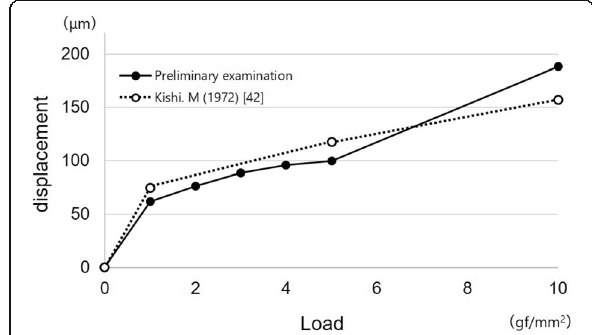
Fig. 6 Load displacement curve for the simulated mucosa. Black circles indicate data for the preliminary examination of the simulated mucosa in this study; white circles indicate data from Kishi M